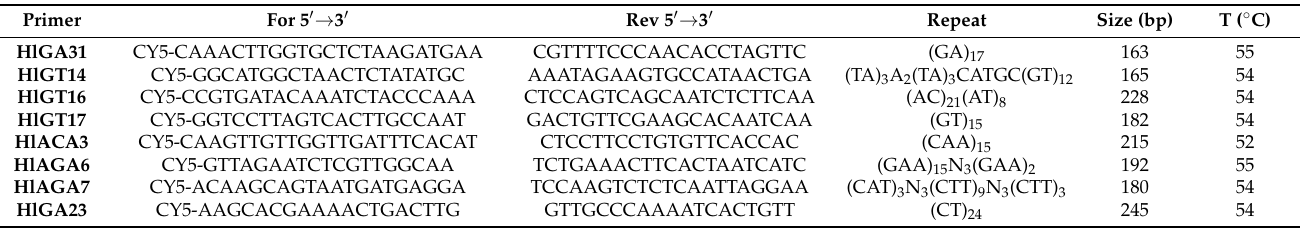
Table 2. List of the SSR primers used, with repeated motif, allele size in base pairs (bp) and anneal- ing